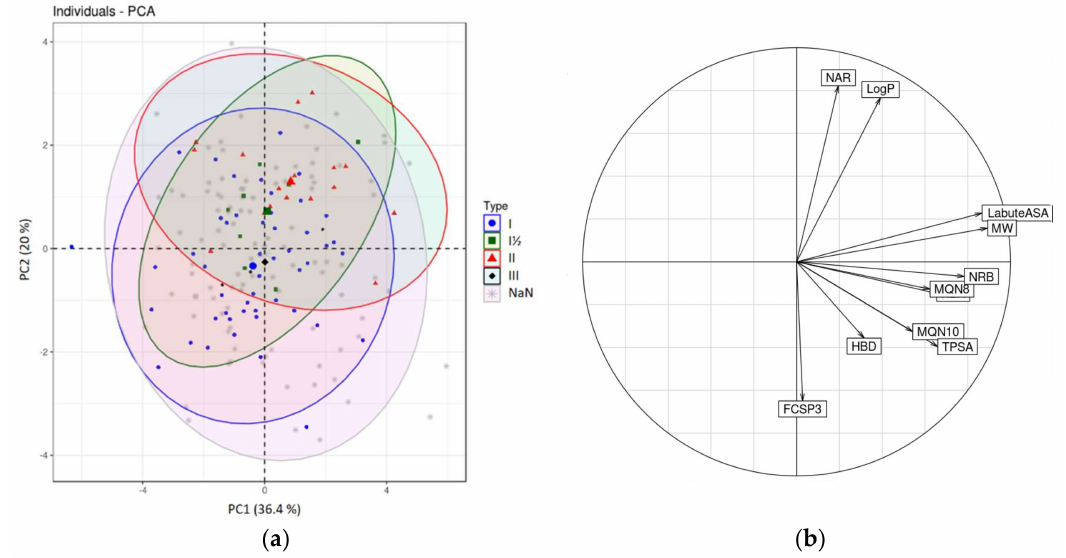
Figure 6. ( a ) PCA of PKIs colored by inhibitor type. Ellipses encompass 95% of individuals of each respective inhibitor type except for Type-III inhibitors because there were too few data points. “NaN” is also defined as “unknown kinase inhibitor Type”; ( b ) Corresponding correlation